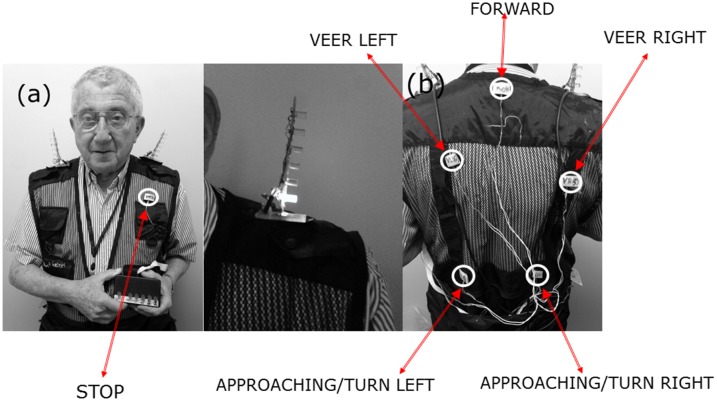
Vibrotactile mobility feedback system is a vibrotactile complement to the Audible Mobility Feedback System.(a) Arditti outfitted with the Vibrotactile Mobility Feedback System (vMFS) with an activated left turn command displayed on LED Array (centre) (b) Back view of vMFS showing placement of vibration motors on upper torso.